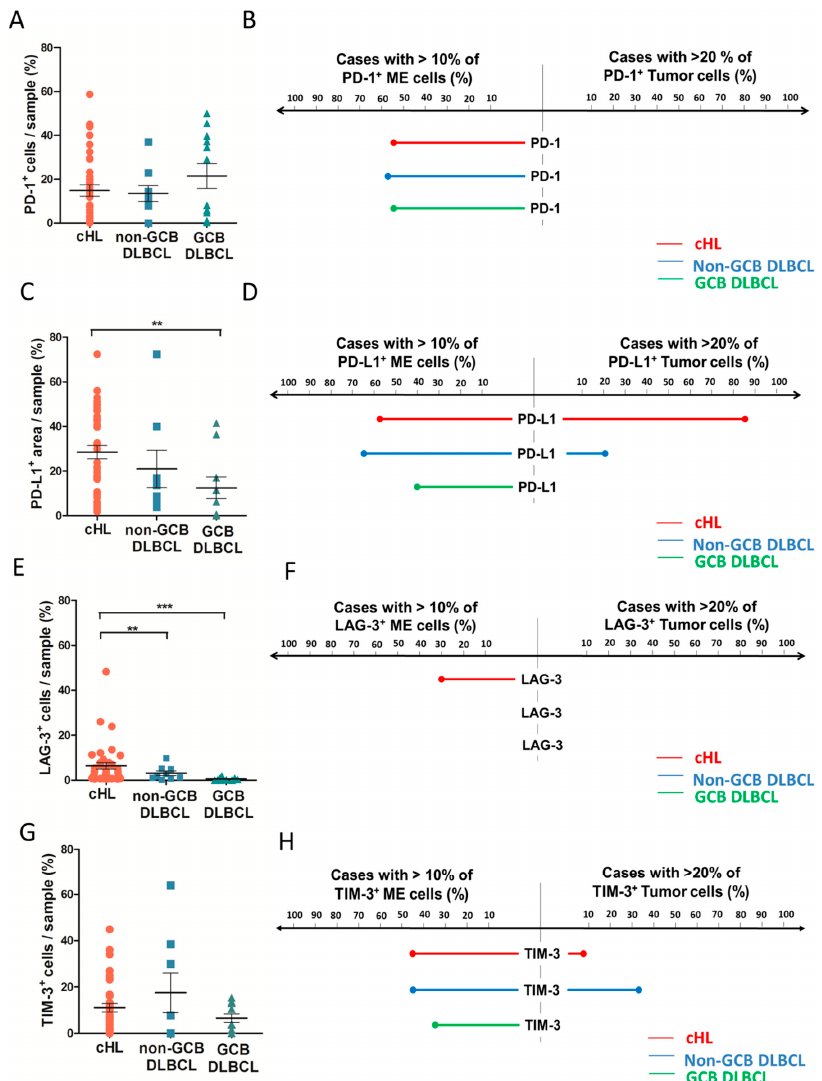
Figure 4. Quantification and cellular distribution of immune checkpoint expression in classical Hodgkin’s lymphoma and in diffuse large B-cell lymphoma from our cohort, by immunohistochemical studies. ( A ) Scoring of total PD-1 + cells/sample in cHL, non-GCB DLBCL and GCB DLBCL samples based on automated analysis. ( B ) Cellular distribution of PD-1 staining between tumor compartment (right) and micro-environment compartment (left) for cHL (red), non-GCB DLBCL (blue), and GCB DLBCL (green), with cutoff at >10% of ME immune cells and >20% of tumor cells. ( C ) Quantification of total PD-L1 + area/sample (% of area positive) in cHL, non-GCB DLBCL, and GCB DLBCL samples based on automated analysis. ( D ) Cellular distribution of PD-L1 staining between tumor compartment (right) and micro-environment compartment (left) for cHL (red), non-GCB DLBCL (blue), and GCB DLBCL (green) with cutoff at >10% of ME immune cells and >20% of tumor cells. ( E ) Quantification of total LAG-3 + cells/sample (% of cells positive) in cHL, non-GCB DLBCL, and GCB DLBCL samples based on automated analysis. ( F ) Cellular distribution of LAG-3 staining between tumor compartment (right) and micro-environment compartment (left) for cHL (red), non-GCB DLBCL (blue), and GCB DLBCL (green) with cutoff at >10% of ME immune cells and >20% of tumor cells. ( G ) Quantification of total TIM-3 + cells/sample (% of cells positive) in cHL, non-GCB DLBCL, and GCB DLBCL samples based on automated analysis. ( H ) Cellular distribution of TIM-3 staining between tumor compartment (right) and micro-environment compartment (left) for cHL (red), non-GCB DLBCL (blue), and GCB DLBCL (green) with cutoff at >10% of ME immune cells and >20% of tumor cells. (* p < 0.05, ** p ≤ 0.01, *** p ≤